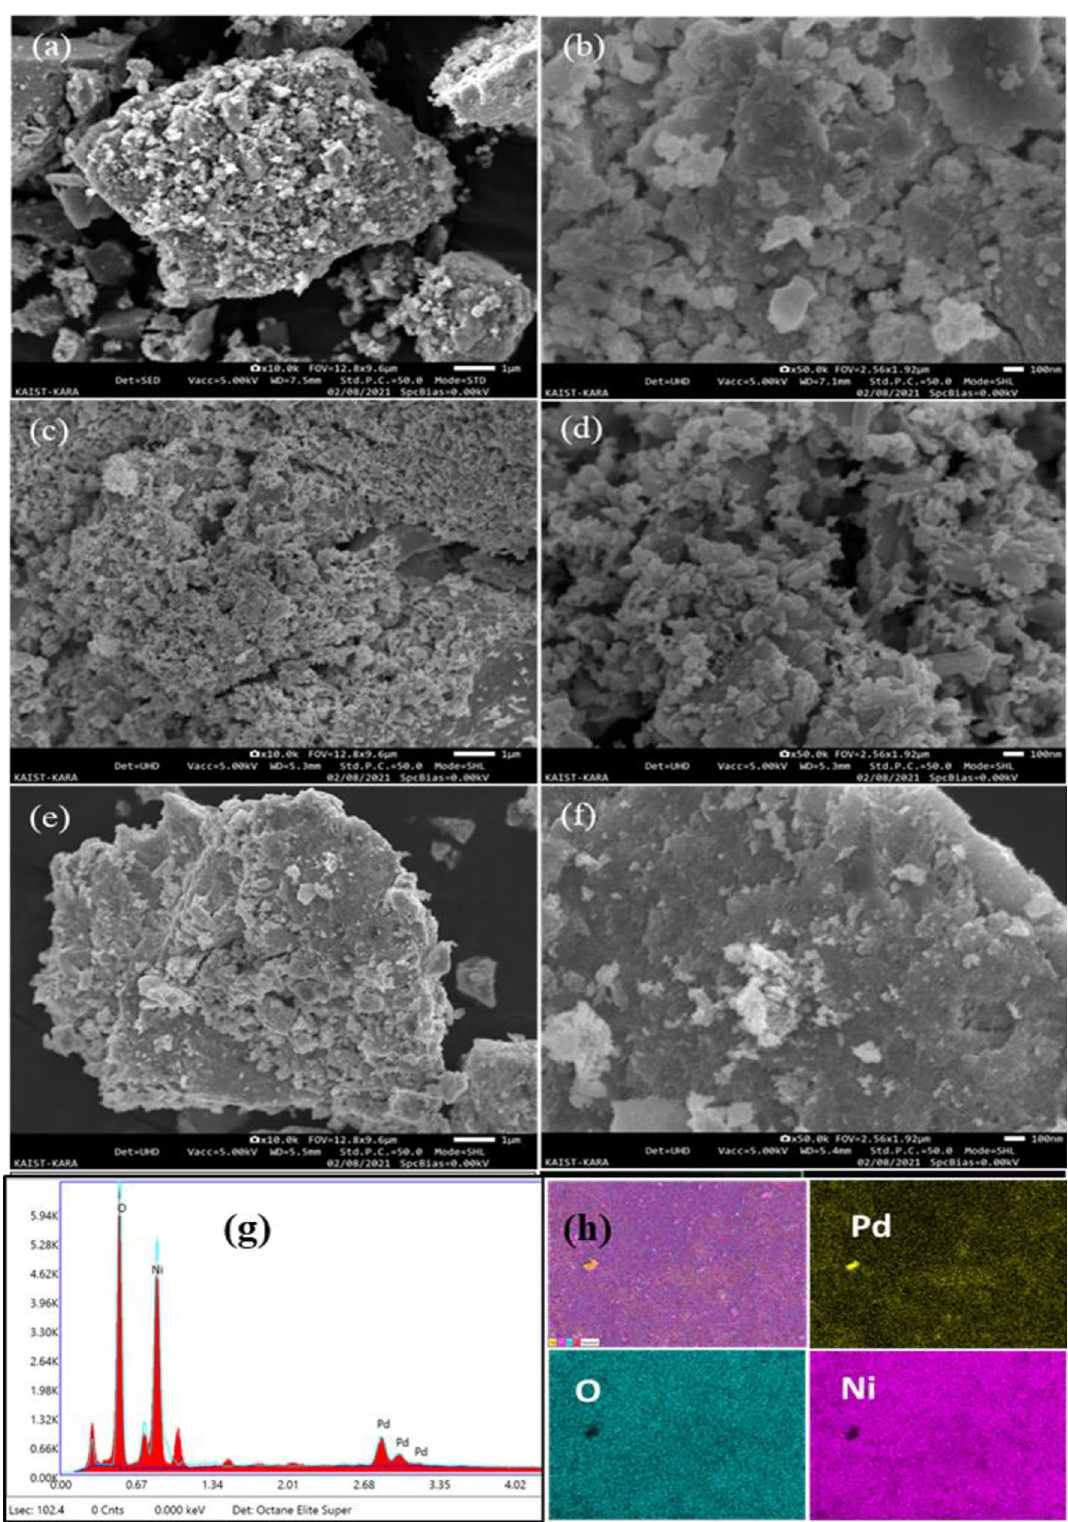
Figure 3. FESEM images ( a , b ) NiO ( c , d ) PdO, ( e , f ) PdO–NiO and ( g , f ) EDS spectra and elemental mapping of PdO–NiO